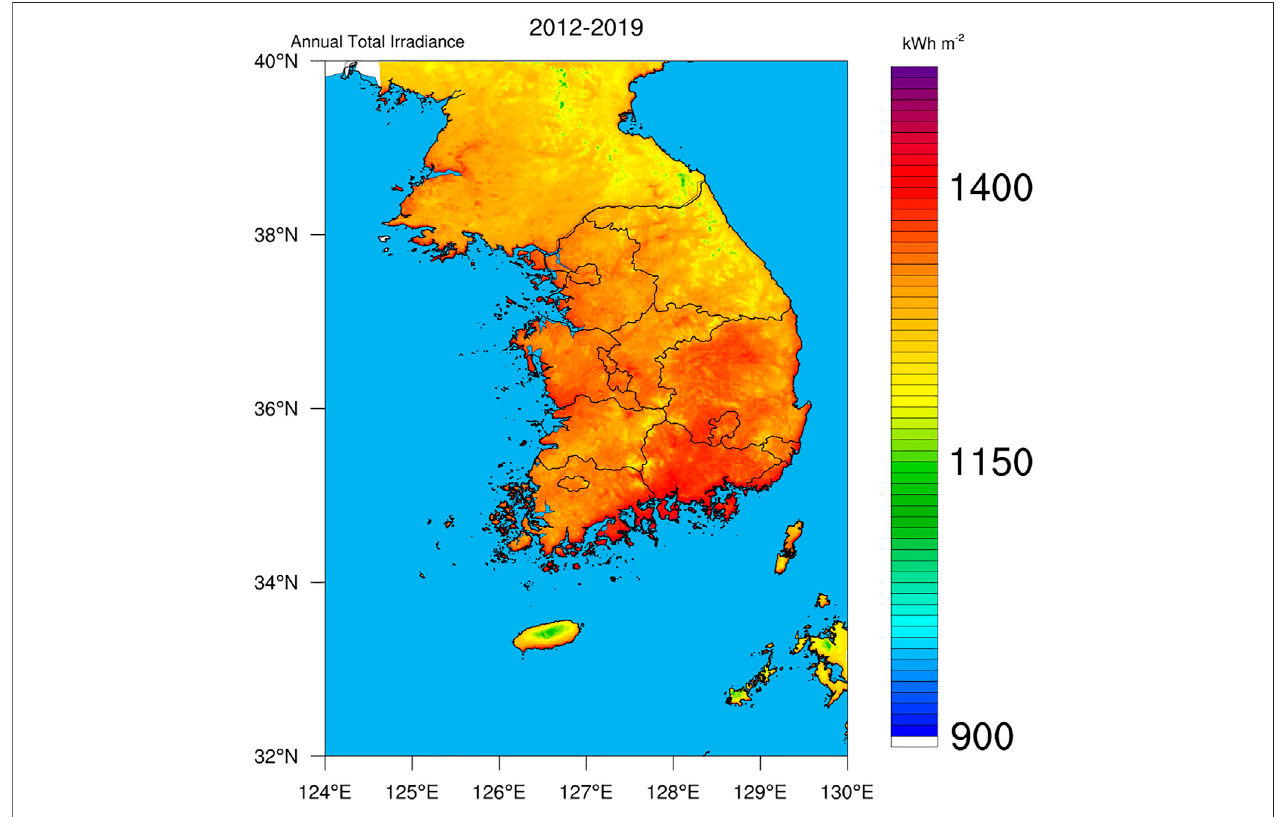
FIGURE 3 | Horizontal distribution of annual total irradiance from 2012 to